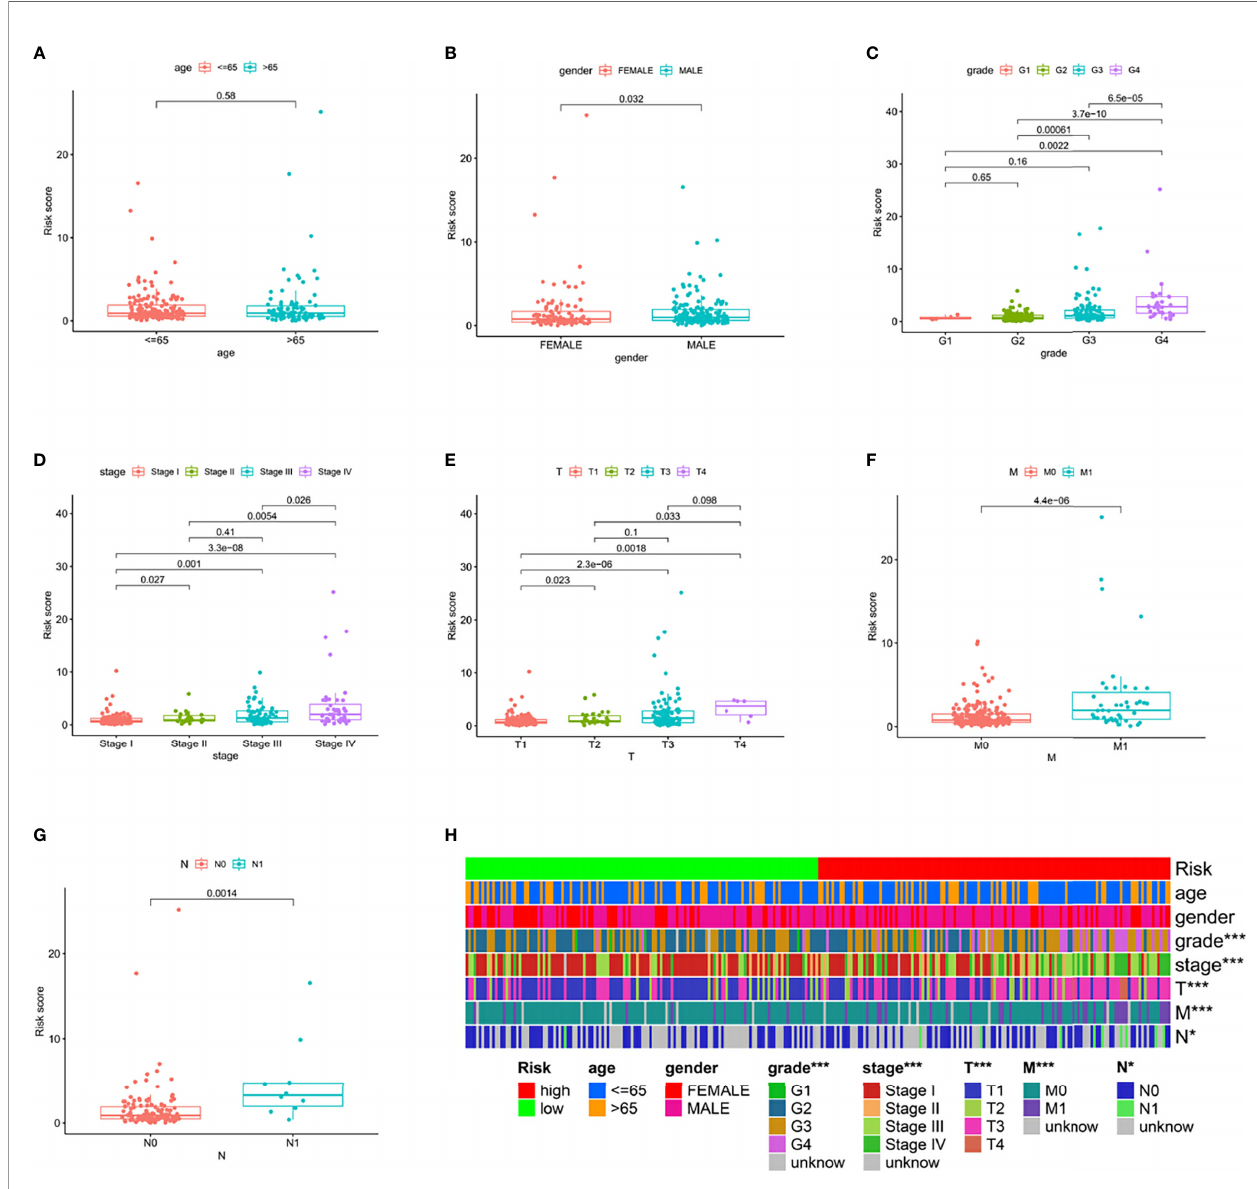
FIGURE 3 | Clinical characteristic evaluation by the risk assessment model. (A – G) Different clinical characteristics, including (A) age, (B) gender, (C) tumor stage, (D) clinical stage, (E) T stage, (F) M stage, and (G) N stage assessed by the risk model. (H) A hot plot of clinical characteristics and risk